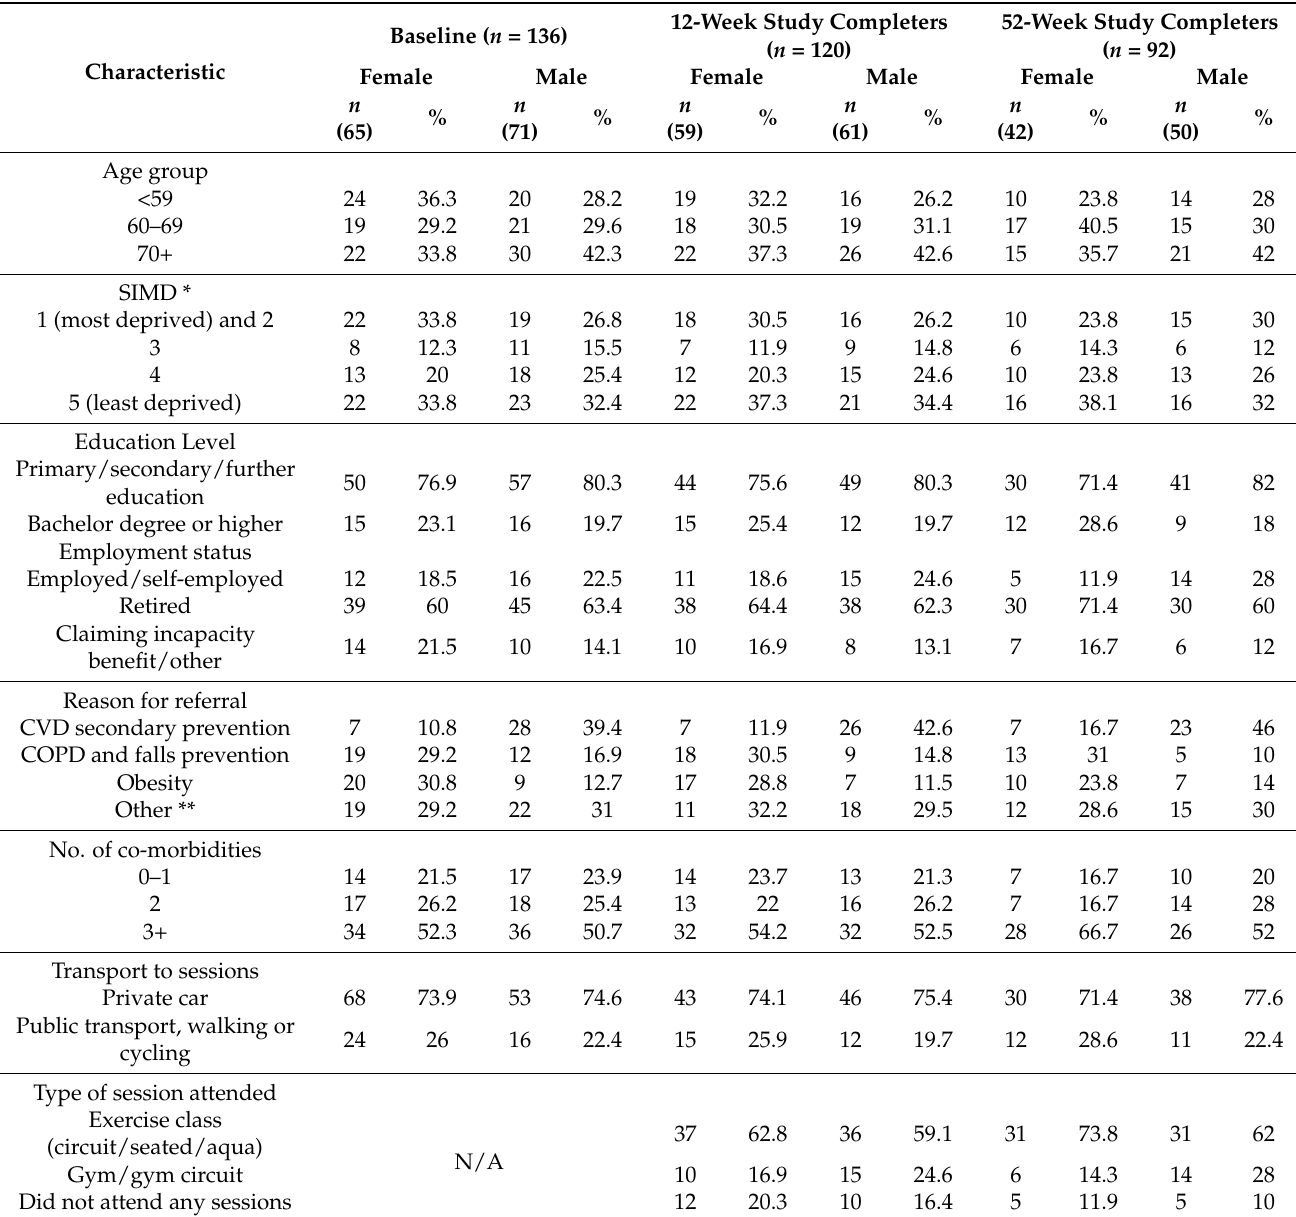
Table 3. Participant characteristics by gender at baseline, 12 and 52